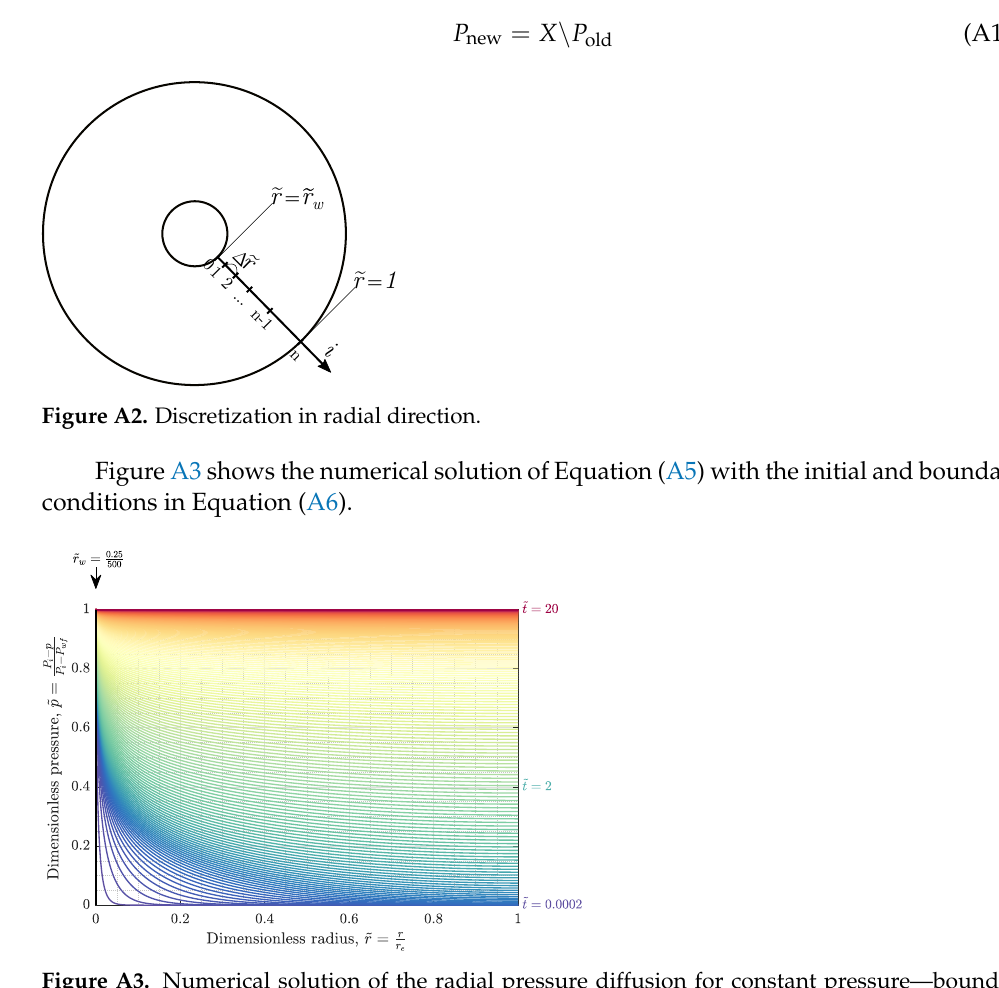
Figure A3. Numerical solution of the radial pressure diffusion for constant pressure—bounded reservoir ( r e = 500